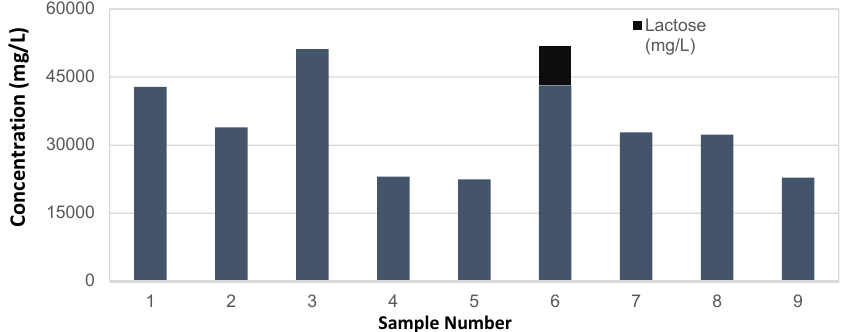
Figure 3. Comparison of malt (maltooligosaccharides) and lactose concentrations for nine beer samples.